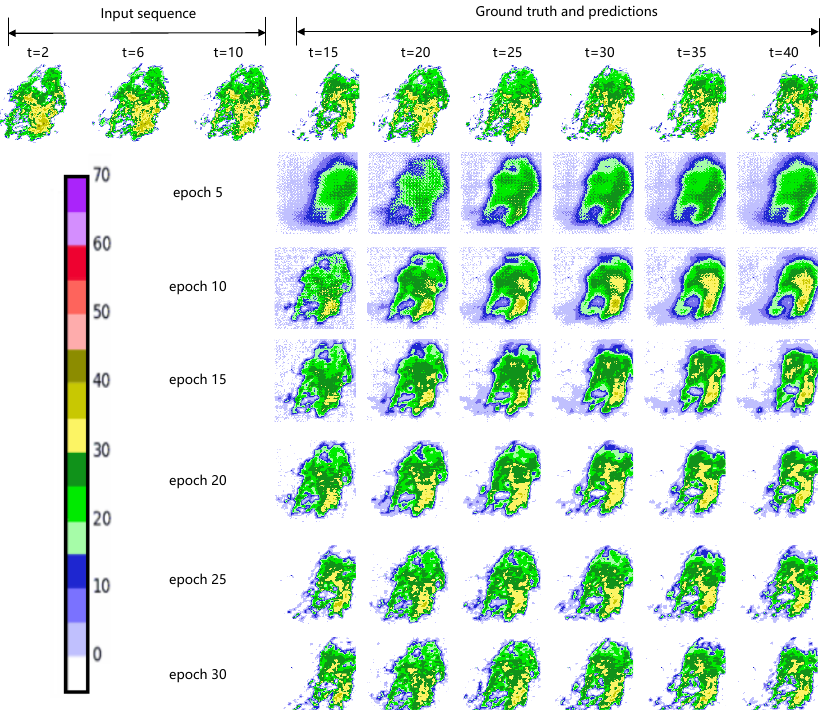
Figure 5. Prediction results of GAN-rcLSTM at different training stages.